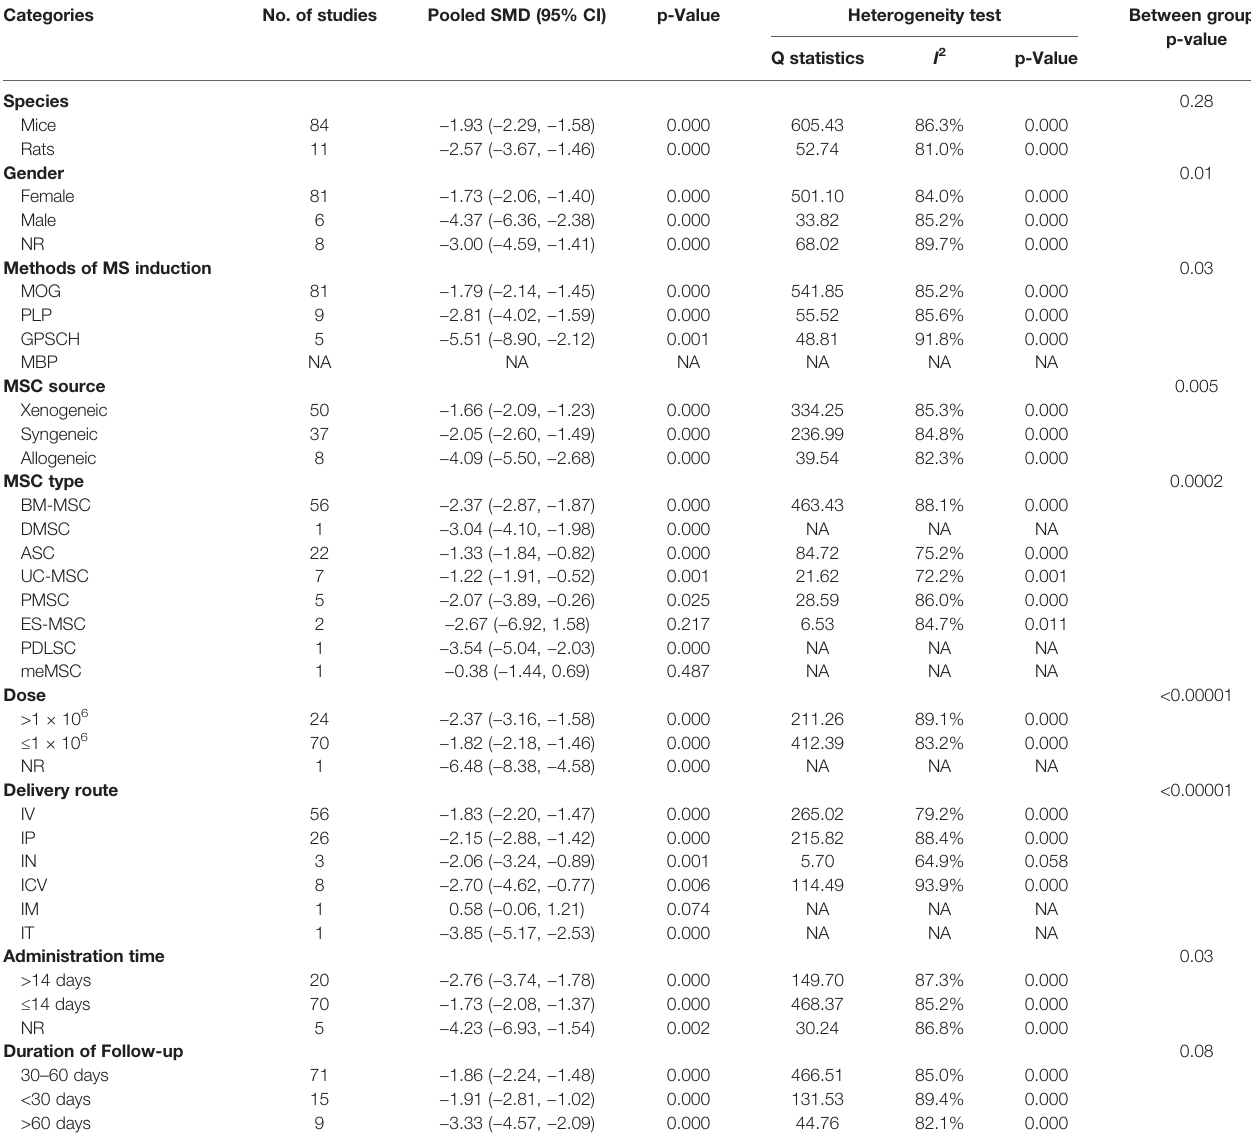
TABLE 2 | Strati fi ed meta-analysis of clinical score. Categories No. of